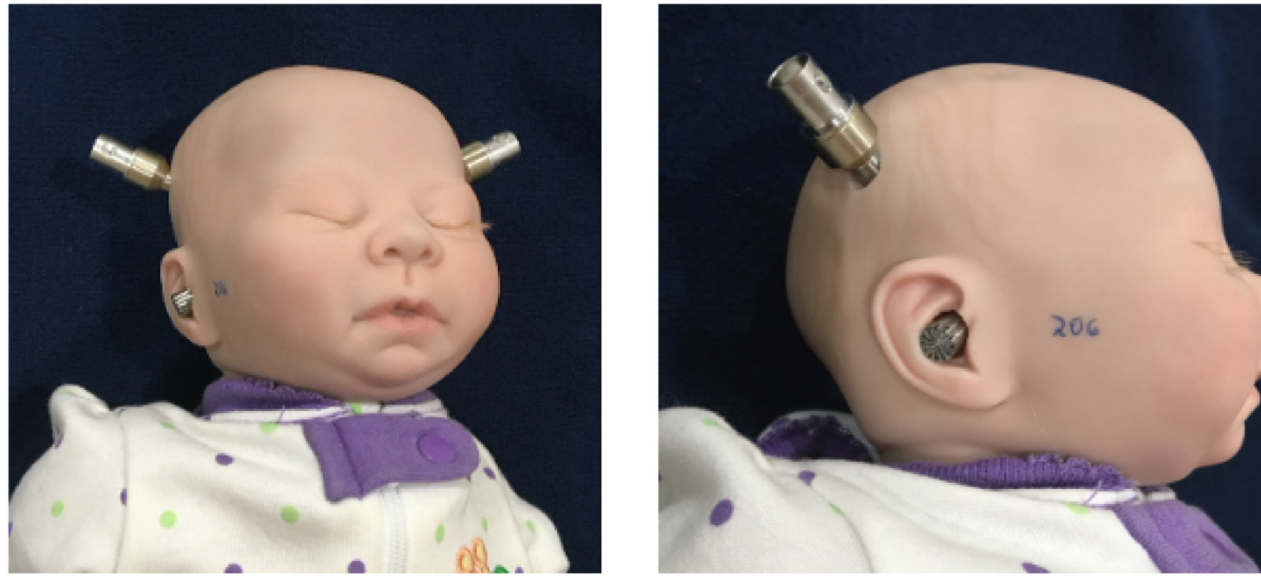
Fig 2. Test mannequin showing microphone placement. Holes were cut in the head of an infant mannequin, permitting the tip of each microphone to emerge from the molded auditory canal. The number written on the cheek of the mannequin indicates the calibration number of that microphone.